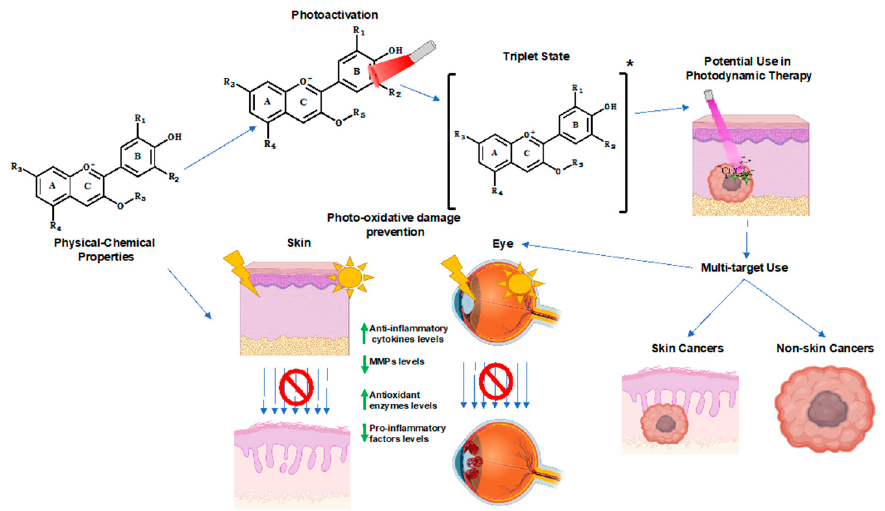
Figure 6. The potential applications of the photoprotective properties of anthocyanins and their related derivatives in biological systems. R 1 = H, OH or OCH 3 ; R 2 = H, OH or OCH 3 ; R 3 = OH or sugar moiety; R 4 = OH or sugar moiety; R 5 = sugar moiety. The sugar moiety of anthocyanins can be composed by di ff erent attached molecules. [Anthocyanin]* denotes the triplet